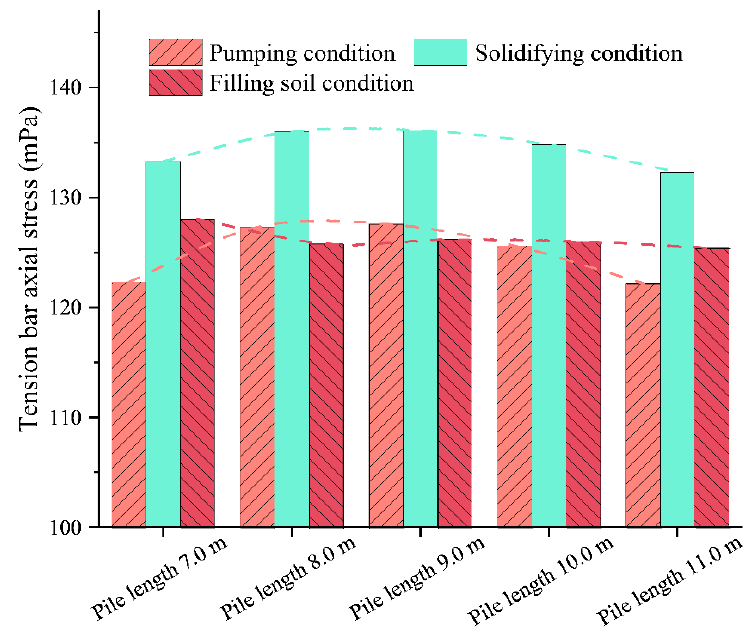
Figure 14. Tension bar axial stress of different pile length conditions.